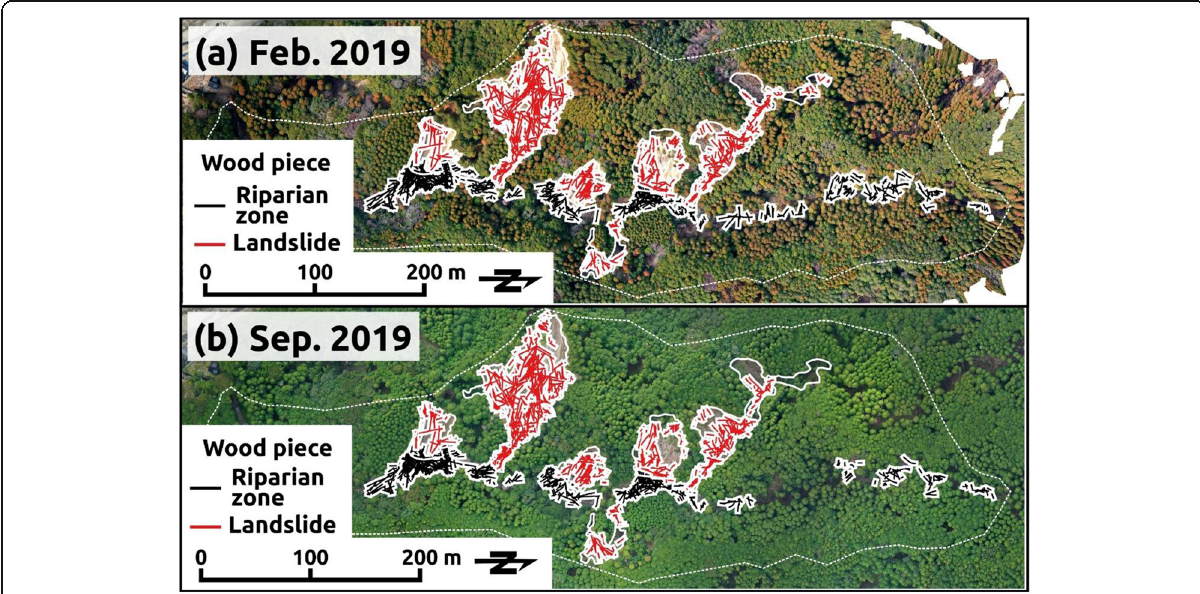
Fig. 10 Spatial distribution of extracted wood pieces at the coniferous forest (CF) site: a February 14, 2019, and b September 26,